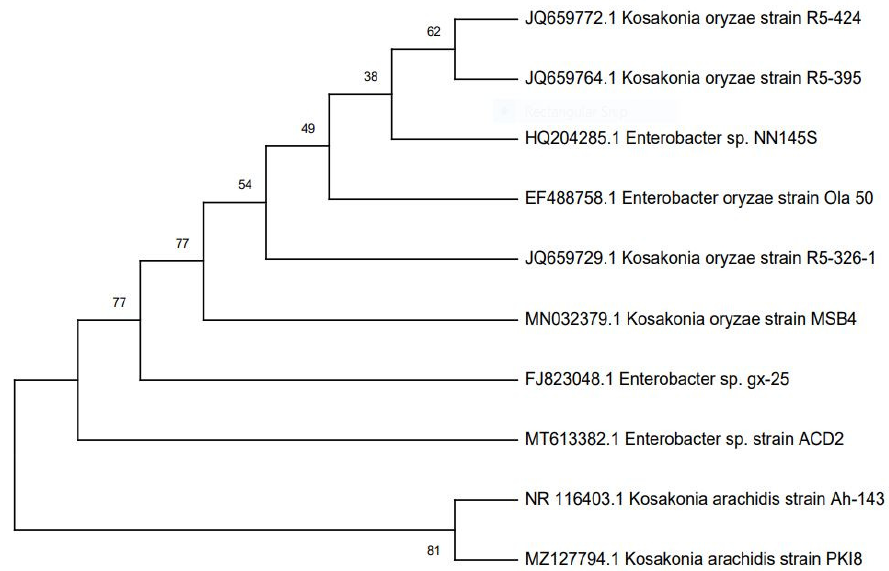
Figure 7. Phylogenetic tree (Neighbor-Joining consensus tree) on the basis of 16S rRNA sequence of gene showing the distance between strain PKI8 with other strain of Kosakonia species. The numbers over branches represent bootstrap confidence values (%) based on 1000 replicates. The Genbank accessions are shown in